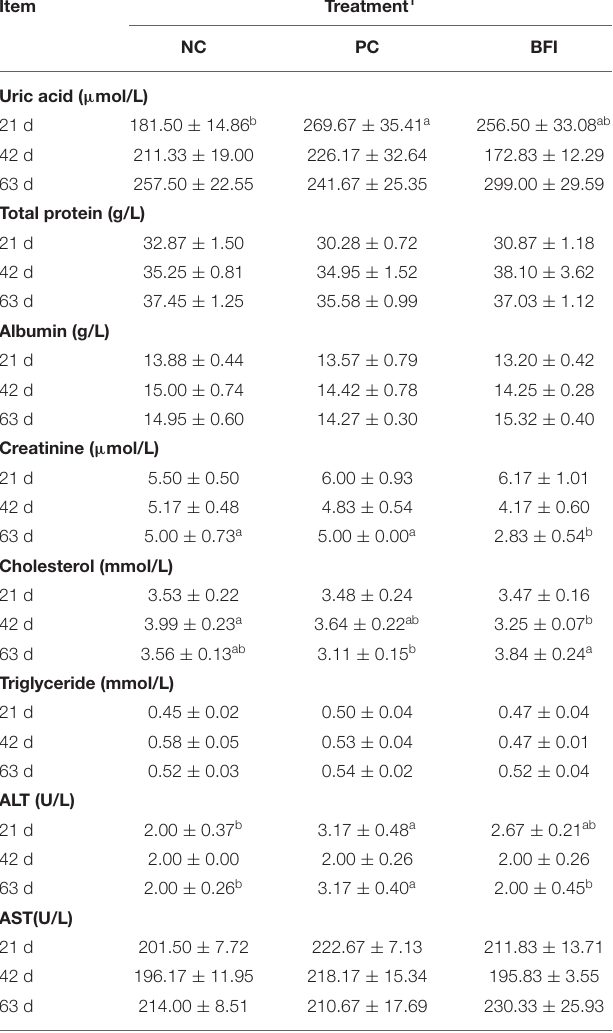
TABLE 4 | Effect of dietary supplementation with heat-inactivated compound probiotics on the organ index in yellow-feathered broilers. Item Treatment